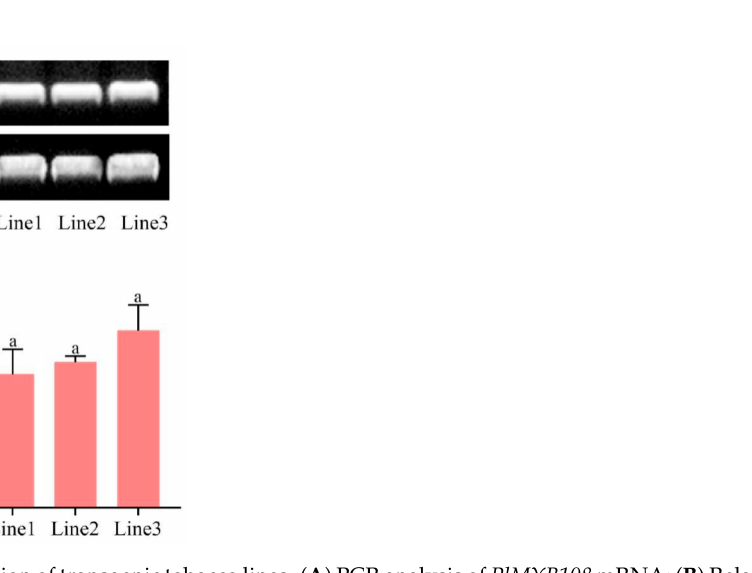
Figure 5. Identification of transgenic tobacco lines. ( A ) PCR analysis of PlMYB108 mRNA; ( B ) Relative expression level of PlMYB108 in leaves using qRT-PCR; the values represent the mean ± SD, and different letters indicate significant differences according to Duncan’s multiple range test ( p < 0.05).